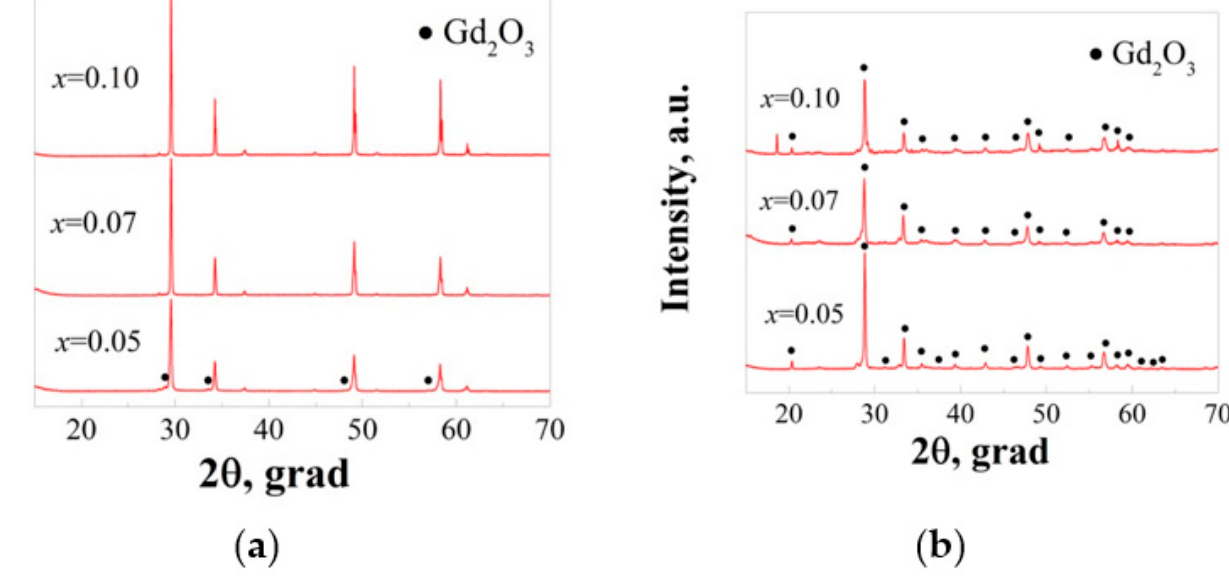
Figure 11. X-ray patterns of (1- x )Gd 2 Zr 2 O 7 · x MgO after exposure at T = 650 ◦ C in ( a ) LiCl melt and ( b ) LiCl-2 wt.% Li 2 O